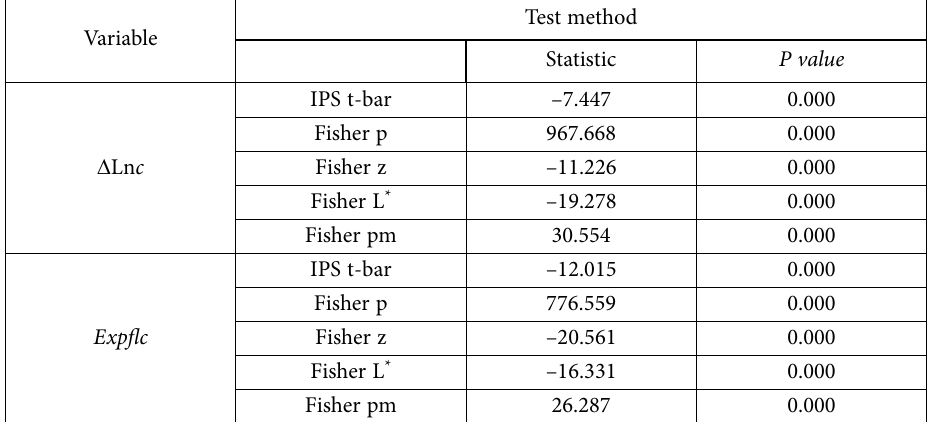
Table 3. Panel unit root test results